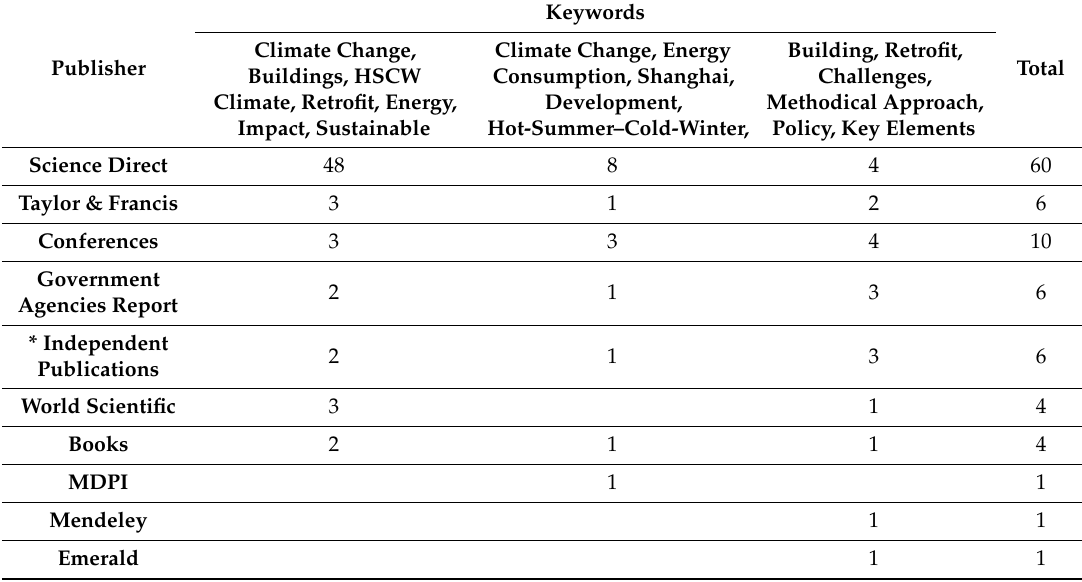
Table 1. Pool of reviewed selected